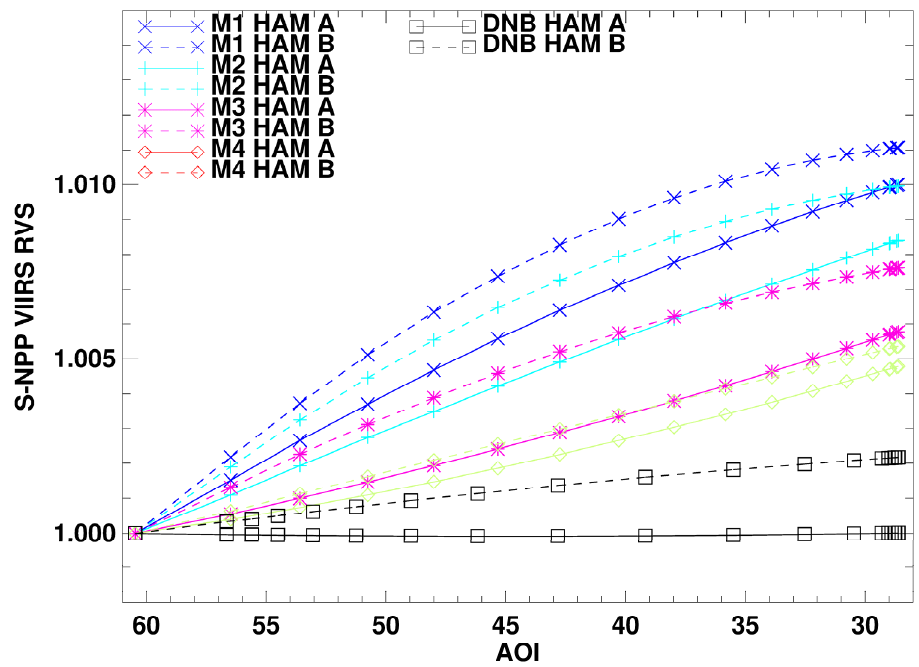
Figure 11. Band-averaged RVS for the Suomi National Polar-orbiting Partnership (S-NPP) VIIRS RSBs from the SV AOI to the end of scan AOI for bands M1–M4.